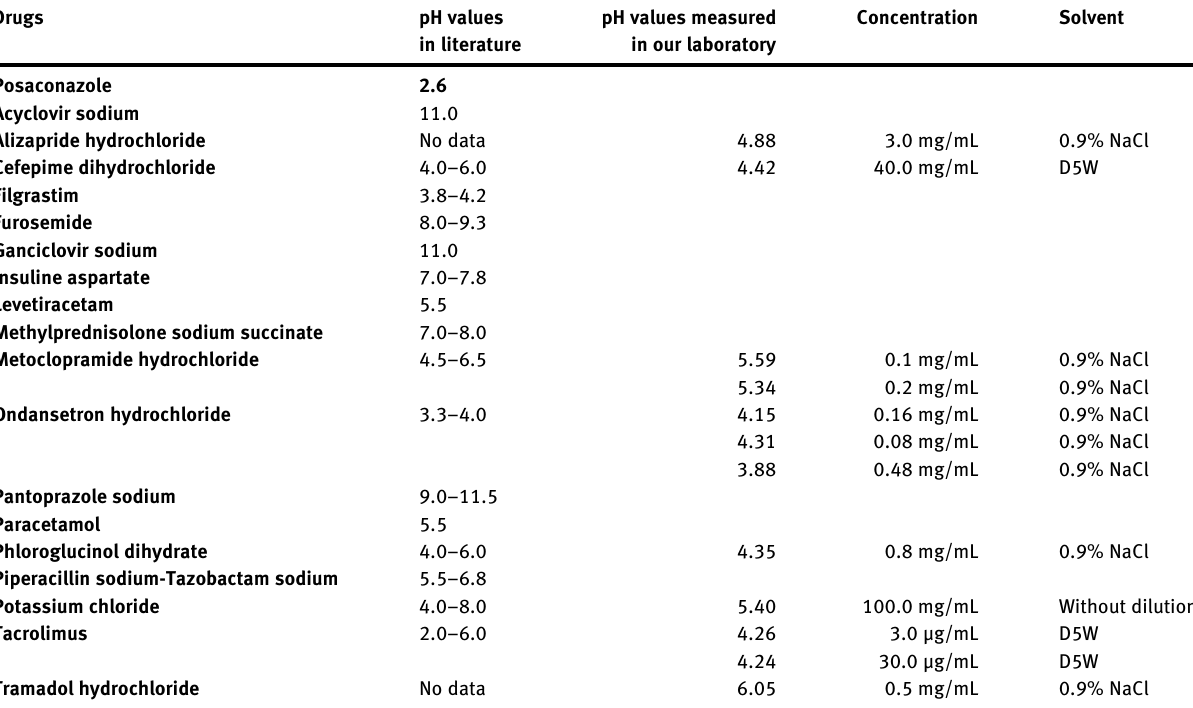
Table  : pH values from the  th edition of the Handbook on injectable drugs and Martindale – the complete drug reference and pH values measured in our